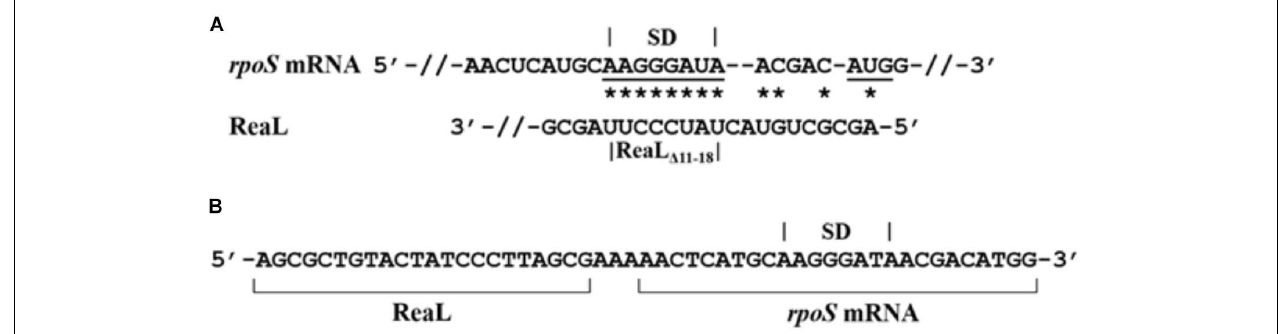
FIGURE 2 | Interaction of ReaL with the TIR of rpoS mRNA. (A) Complementarity of ReaL with the TIR of rpoS mRNA predicted with the IntaRNA algorithm (Mann et al., 2017). Possible base-pairing interactions are denoted by stars. The rpoS SD region and the start codon are underlined, respectively. The deletion of nt 11–18 present in ReaL (cid:49) 11 − 18 is indicated below. (B) ReaL- rpoS mRNA RLM-RT-PCR. The sub-sequence generated by ligation of ReaL with rpoS mRNA is shown. The ReaL and rpoS mRNA sequences are indicated by brackets and the rpoS SD region is denoted on top.